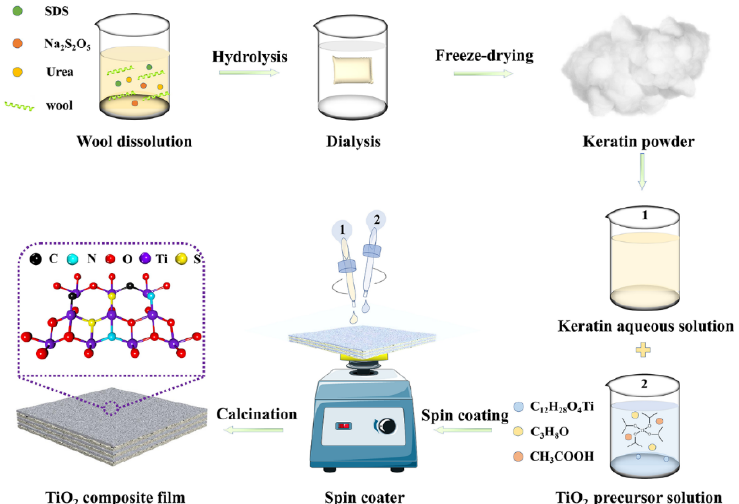
Figure 14. The schematic for the preparation of keratin char-TiO 2 composite films.